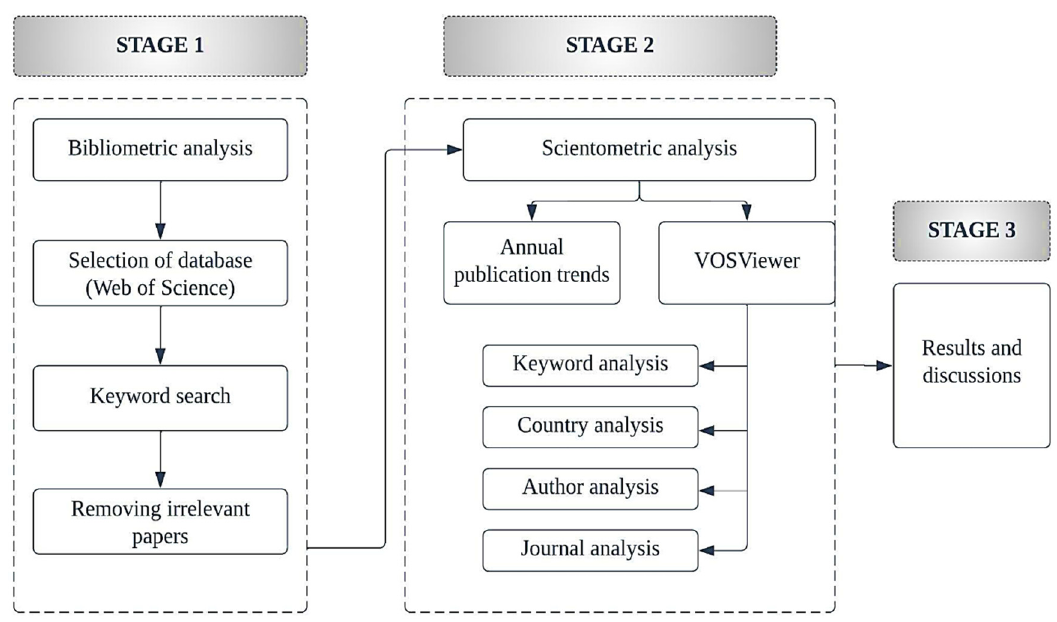
Figure 1. The overall methodology of three-stage scientometric analysis.